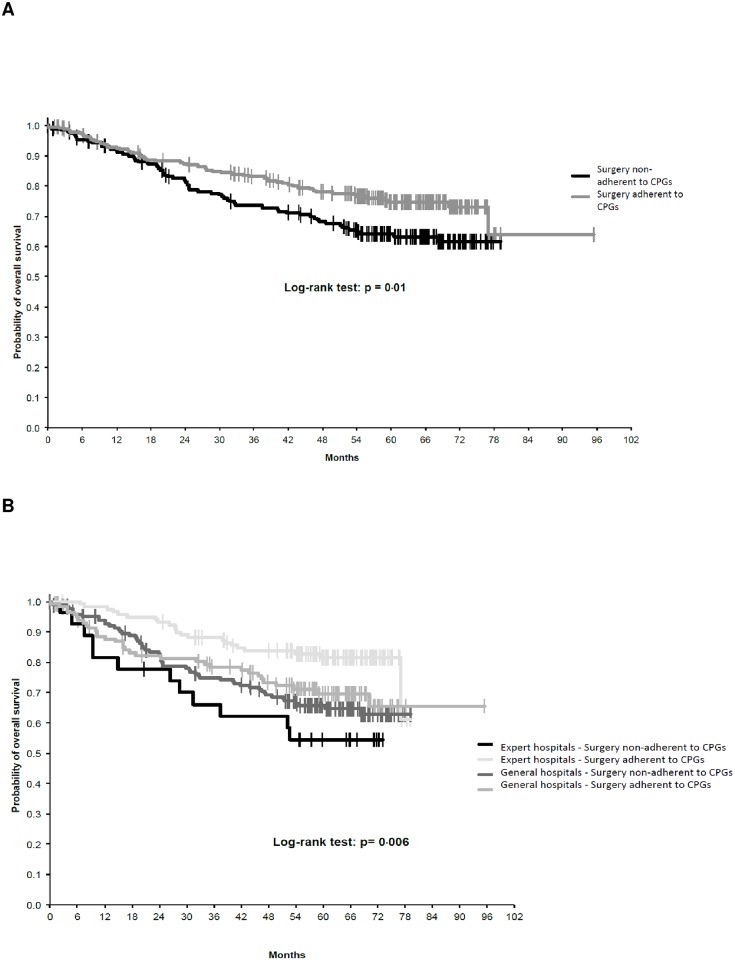
A: Overall survival: Overall survival and adherence to CPGs for surgery. B: Overall survival curves showing the interaction between adherence to CPGs for surgery and treatment centers.